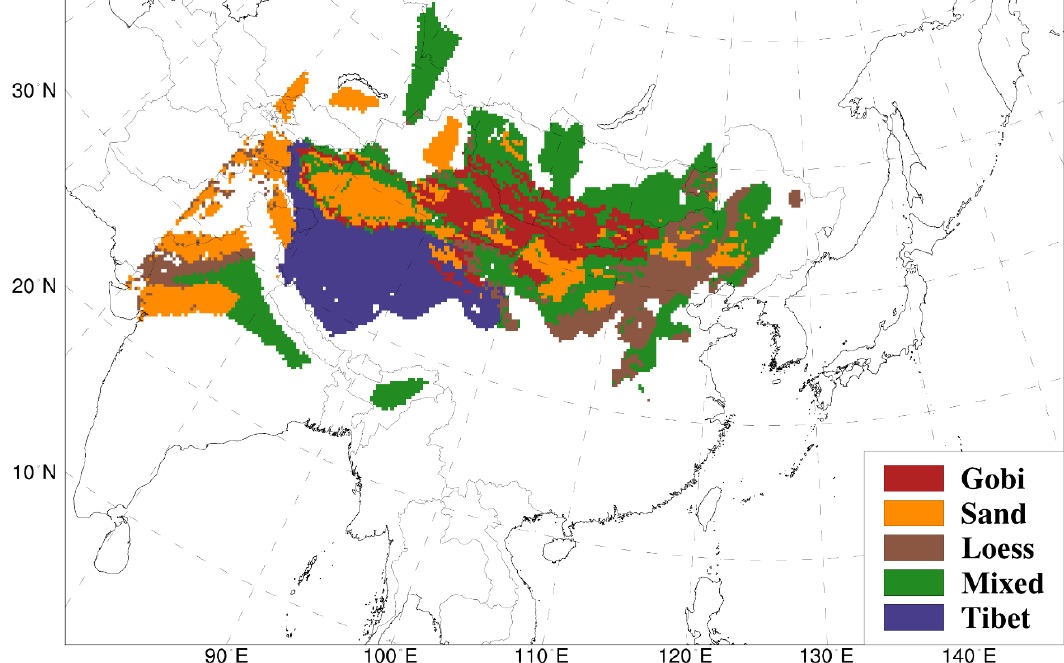
Figure 4. Surface soil types in Asian dust source regions in the ADAM model (after Figure 1 of Park et al. [20]).